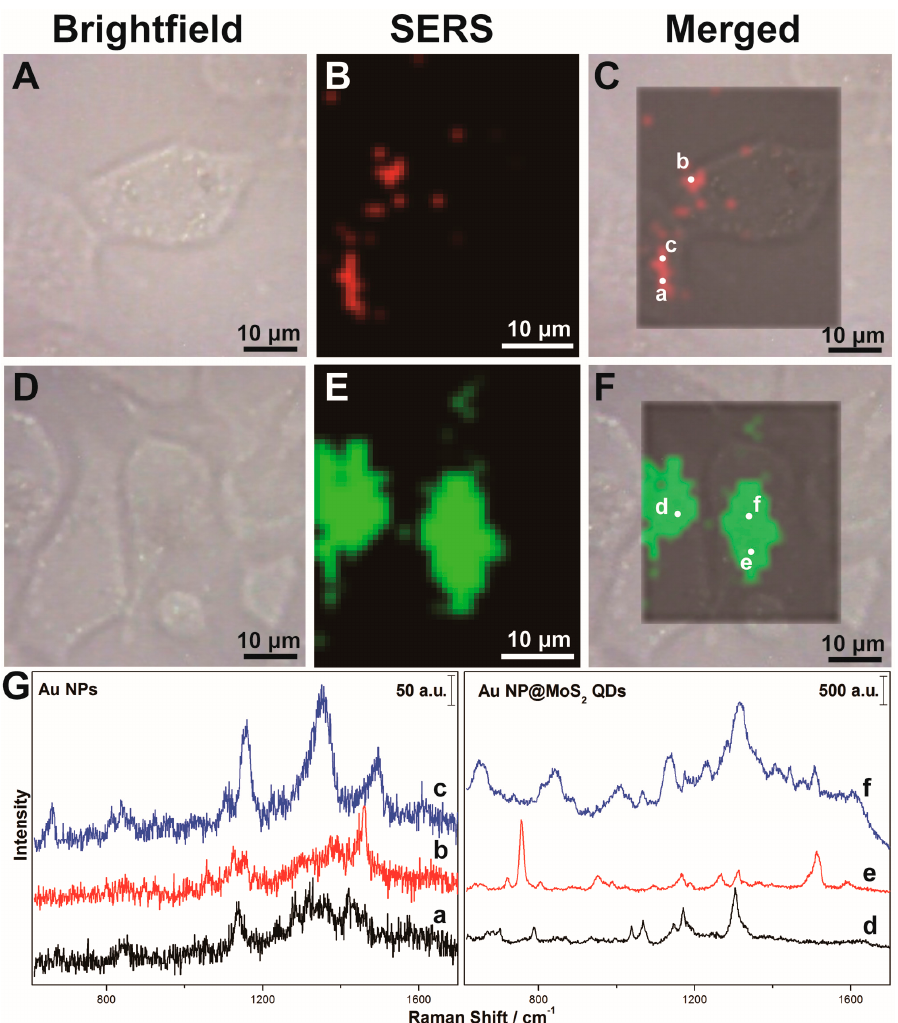
Figure 7. The label-free NIR SERS imaging and detection of 4T1 cells. The images are taken after incubation of Au NPs ( A – C ) and Au NPs@MoS2 QDs ( D – F ). ( G ) The raw SERS spectral lines of different spots randomly marked in the imaging of C and F .